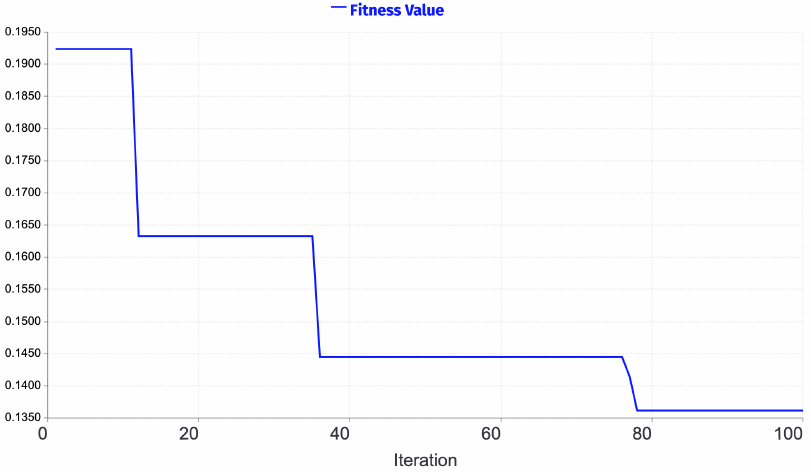
Figure A17. The training convergence curve when using the ANN with the CSO and the accuracy fitness function for the dataset of Polish